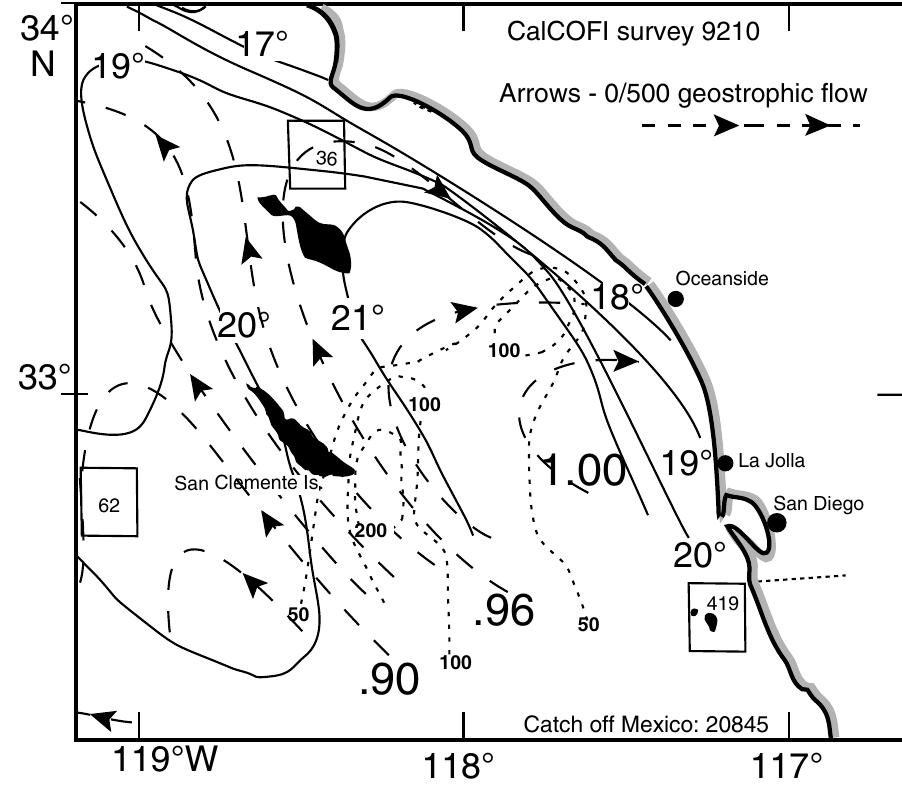
F IG . 2. – Spatial distribution of total CPFV dolphinfish catch in 1992 (dotted, small numbers), ocean temperature at 10m (solid), and geostrophic flow (arrows). Boxes show 0.1° areas with catch greater than 30 fish that were not contoured by standard conventions. Temper- ature at 10 m and dynamic height anomaly (dashed) are from CalCOFI survey 9210. Maximum velocity (about 22 cm/sec) is shown by more closely spaced contours. Figure from Norton and Crooke, 1994.